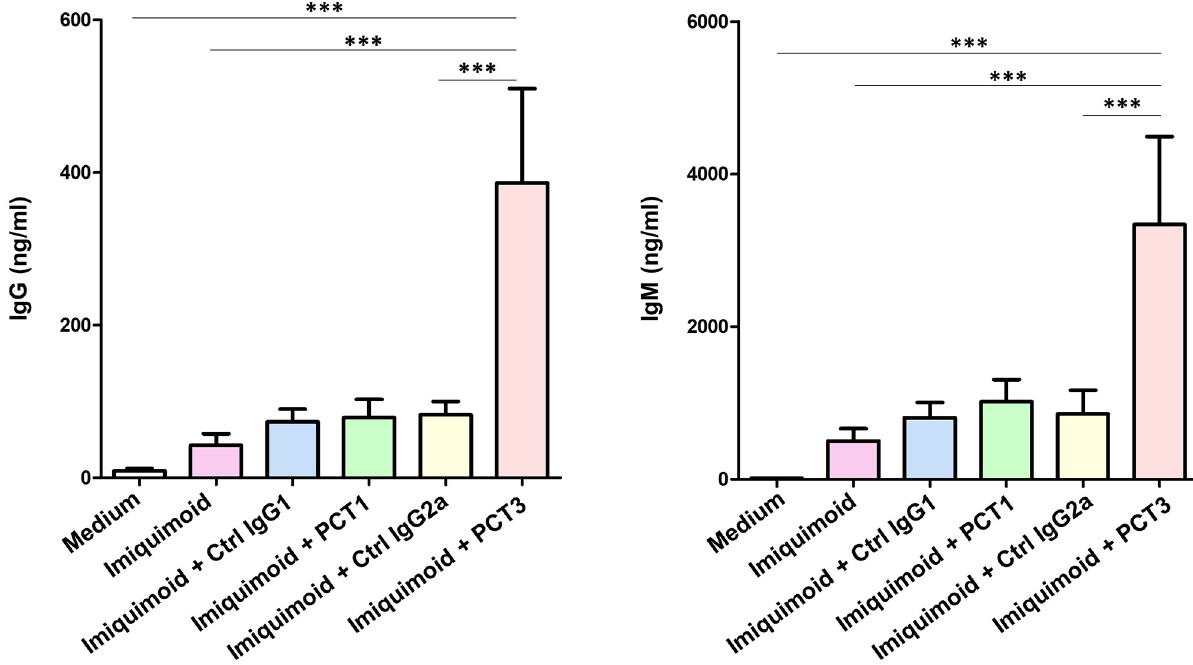
Fig 4. IgG and IgM production after stimulation of PBMC with the TLR7 ligand imiquimoid in the presence of PCT1, PCT3 or isotype-matched control mAbs or medium alone. After seven days supernatants were collected and analysed by ELISA for antibody production. Results shown mean ± SEM from 6 independent experiments. One way ANOVA followed by Bonferroni adjustment was used to assess statistically significant differences. Symbols used: ��� , p �